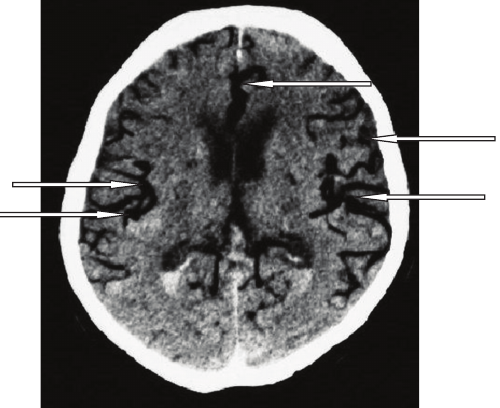
Figure 1: A section of cranial CT scan in the 8th day of admittance. Arrows show arterial air embolism.